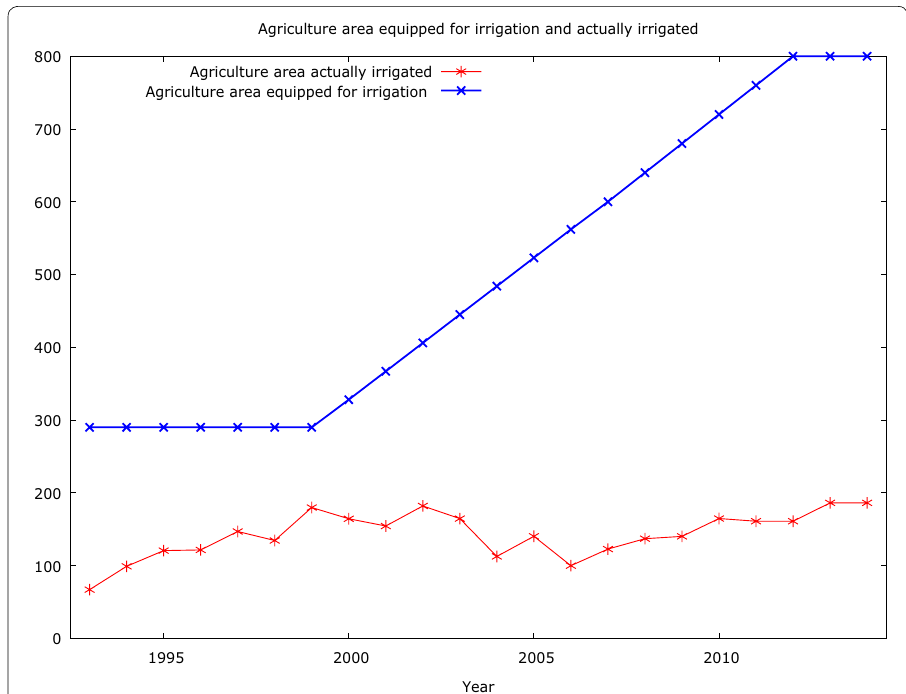
Fig. 1 The gap between actual irrigated and planned areas for irrigation (source: author’s drawing based on FAOSTAT database FAO